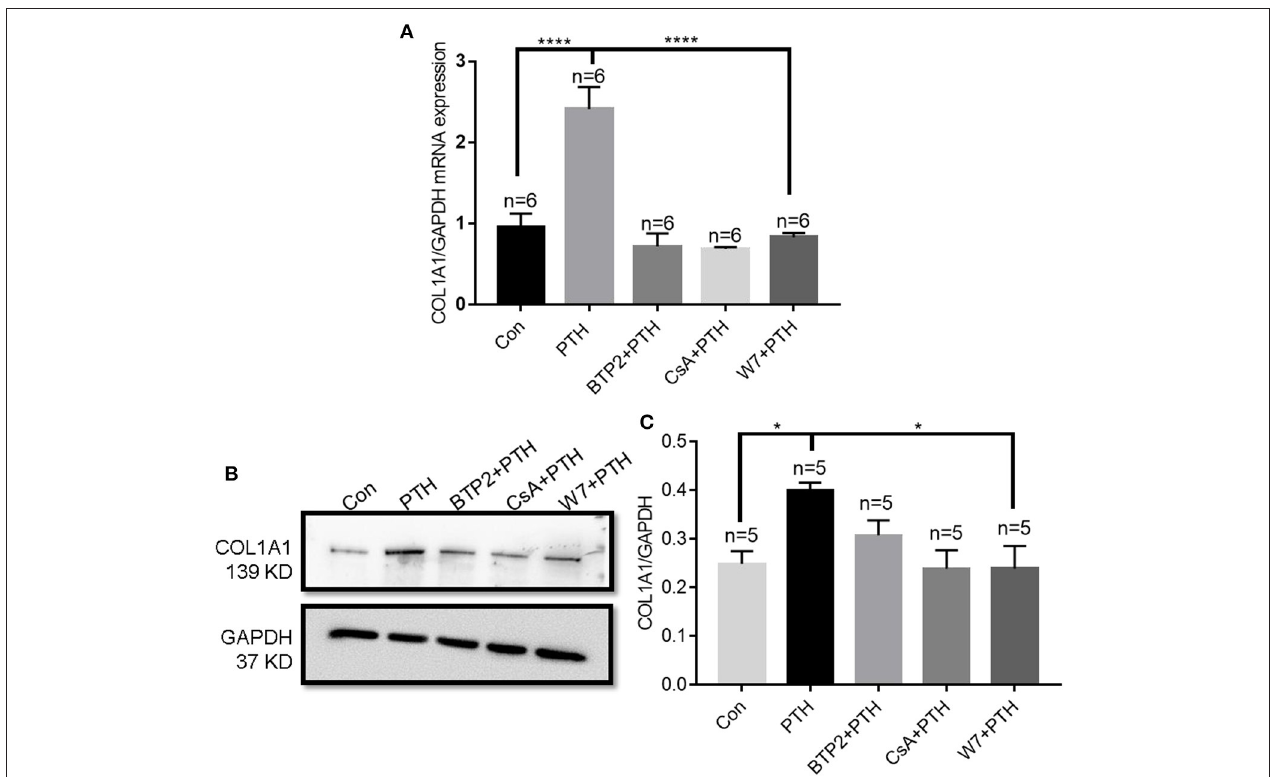
FIGURE 7 | Effect of parathyroid hormone (PTH) on COL1A1 expression in human umbilical vein endothelial cells (HUVECs). (A) After HUVECs were treated with vehicle control, 100 pM PTH, PTH + BTP2 (an Orai nonspecific inhibitor), PTH + CsA (calcineurin inhibitor), or PTH + W7 (calmodulin antagonist) for 24h, COL1A1 mRNA levels were analyzed by qPCR assays. Messenger RNA expression was normalized to that of GAPDH. (B,C) Representative images (B) and summary data (C) showing COL1A1 protein expression in HUVECs after treatment with vehicle control, 100 pM PTH, PTH + BTP2, PTH + CsA or PTH + W7 for 24h. GAPDH expression was referenced as the loading control. Data are shown as the mean ± SEM; n = 5–6. * P < 0.05, **** P < 0.0001 vs. Con or PTH in (A) and (C) analyzed by one-way analysis of variance followed by Dunnett’s multiple comparisons